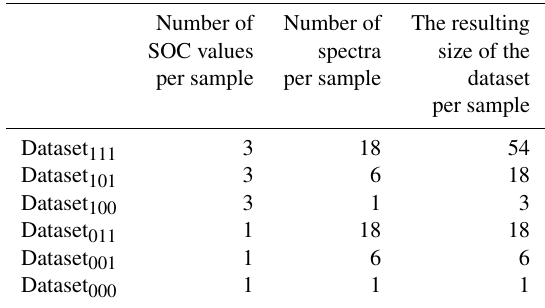
Table 2. Data basis per soil